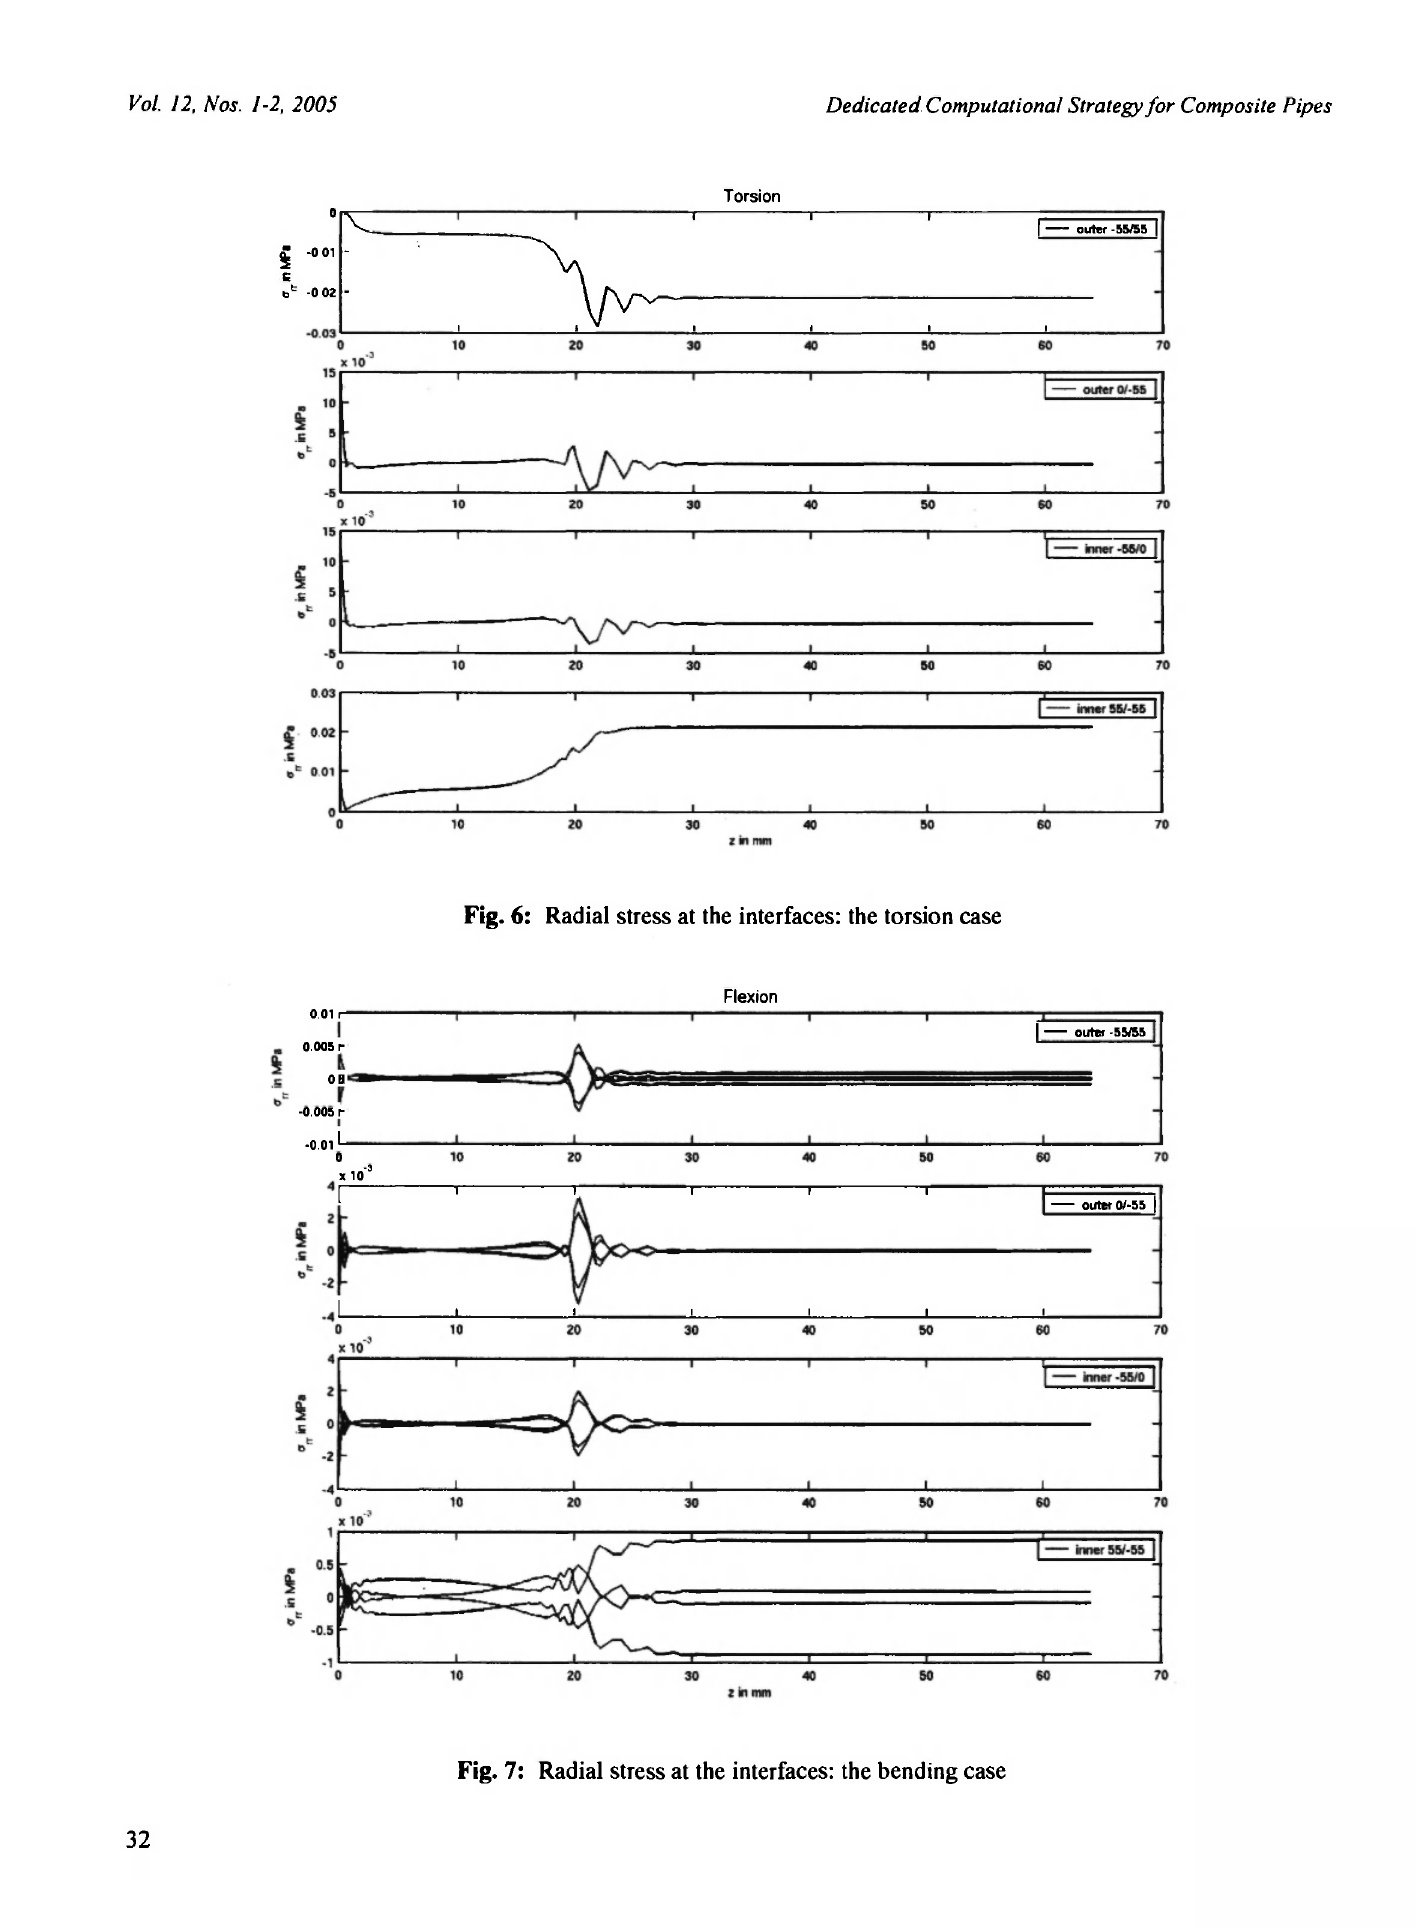
Fig. 7: Radial stress at the interfaces: the bending